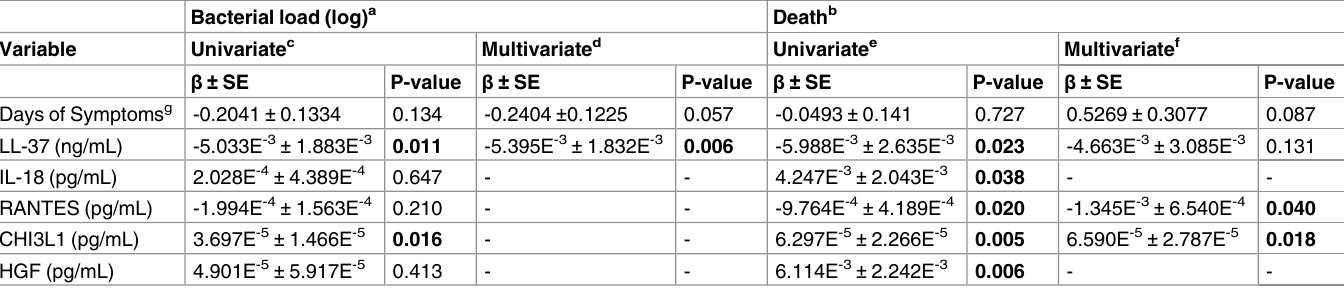
Table 2. Risk factors associated with death in leptospirosis patients.